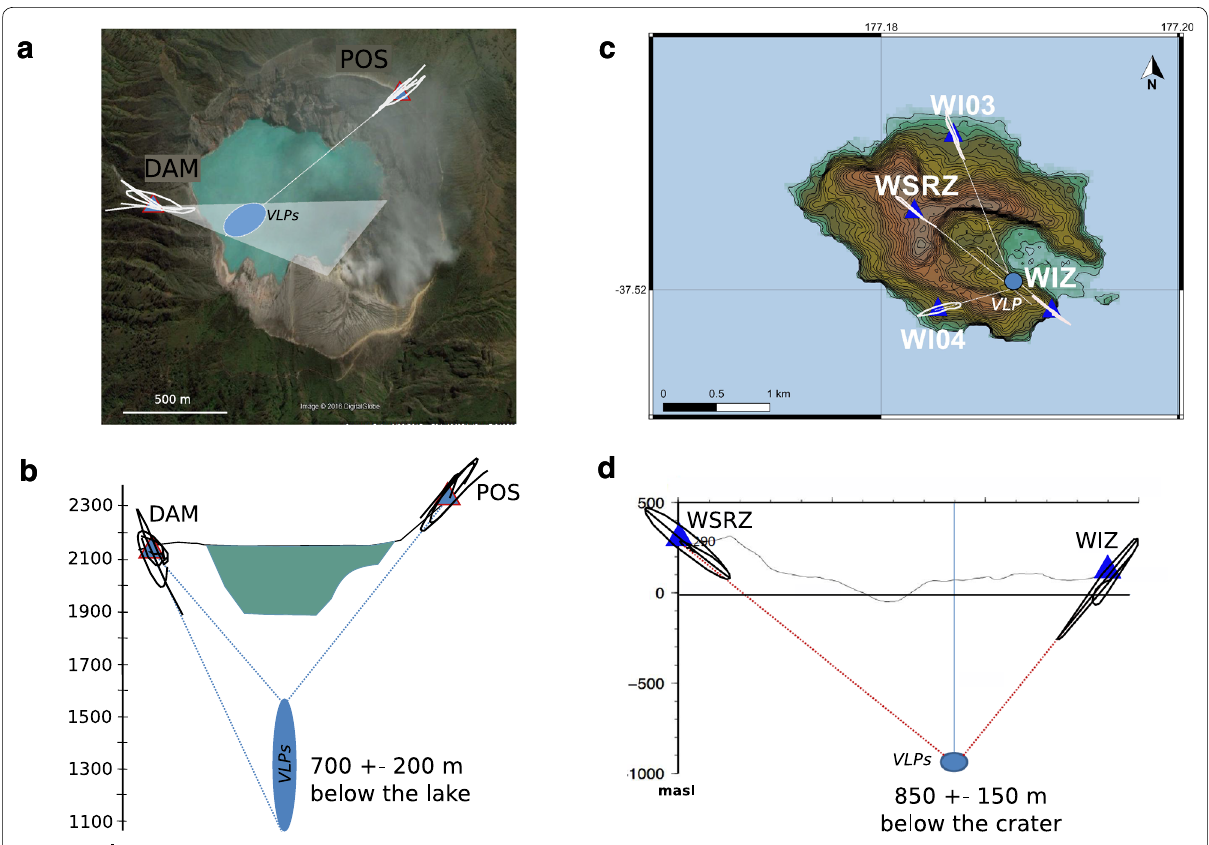
Fig. 7 VLPs location. a Epicentral (blue ellipse) and b depth location for the 3 VLPs recorded at Kawah Ijen and c epicentral (blue circle) and d depth location for the first VLP observed at White Island. The locations are carried out using particle motion analyses [shown in white in ( a ) and ( c ), in black in ( b ) and ( d )]. A surface correction is applied following Neuberg and Pointer (2000). At White Island we also applied the waveform semblance method (Jolly et al.